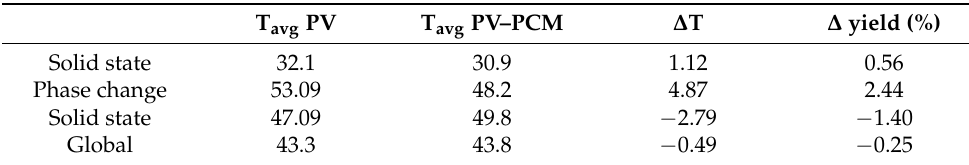
Table 3. Results of the electric yield in the different states.